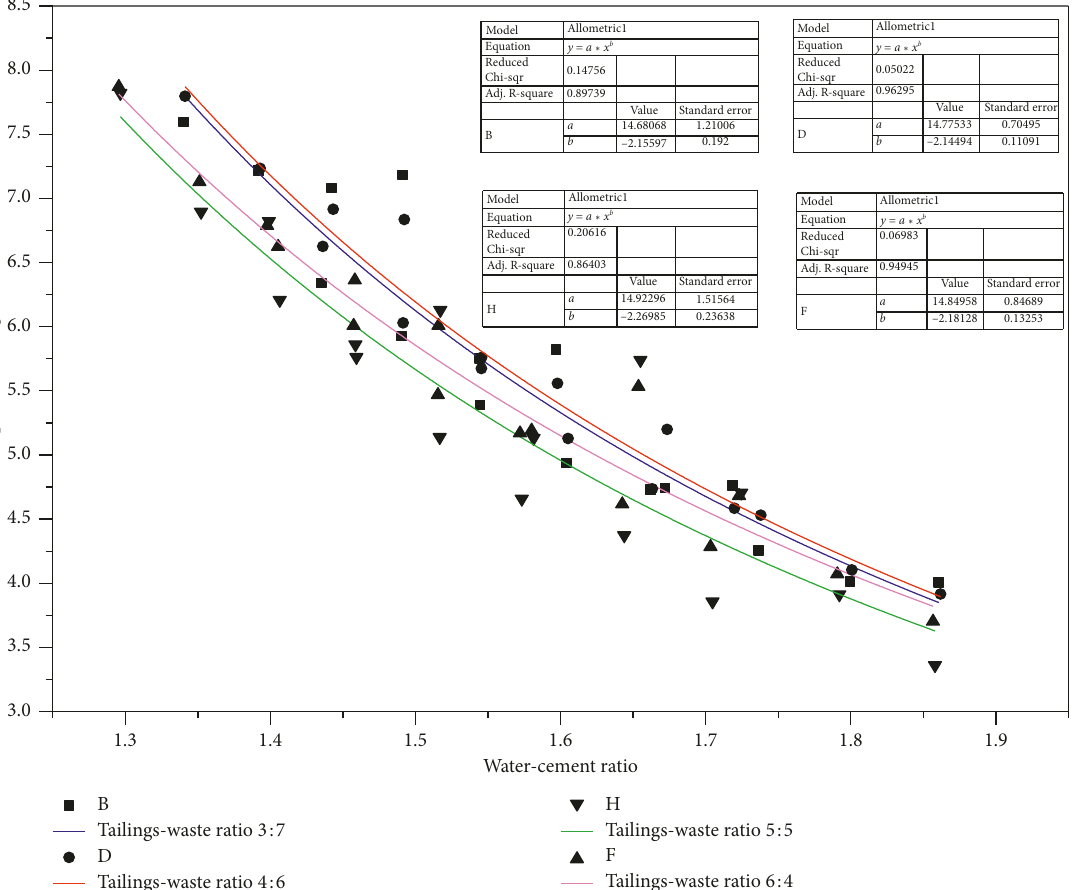
Figure 4: Relationship between normalized UCS and water-cement ratio.